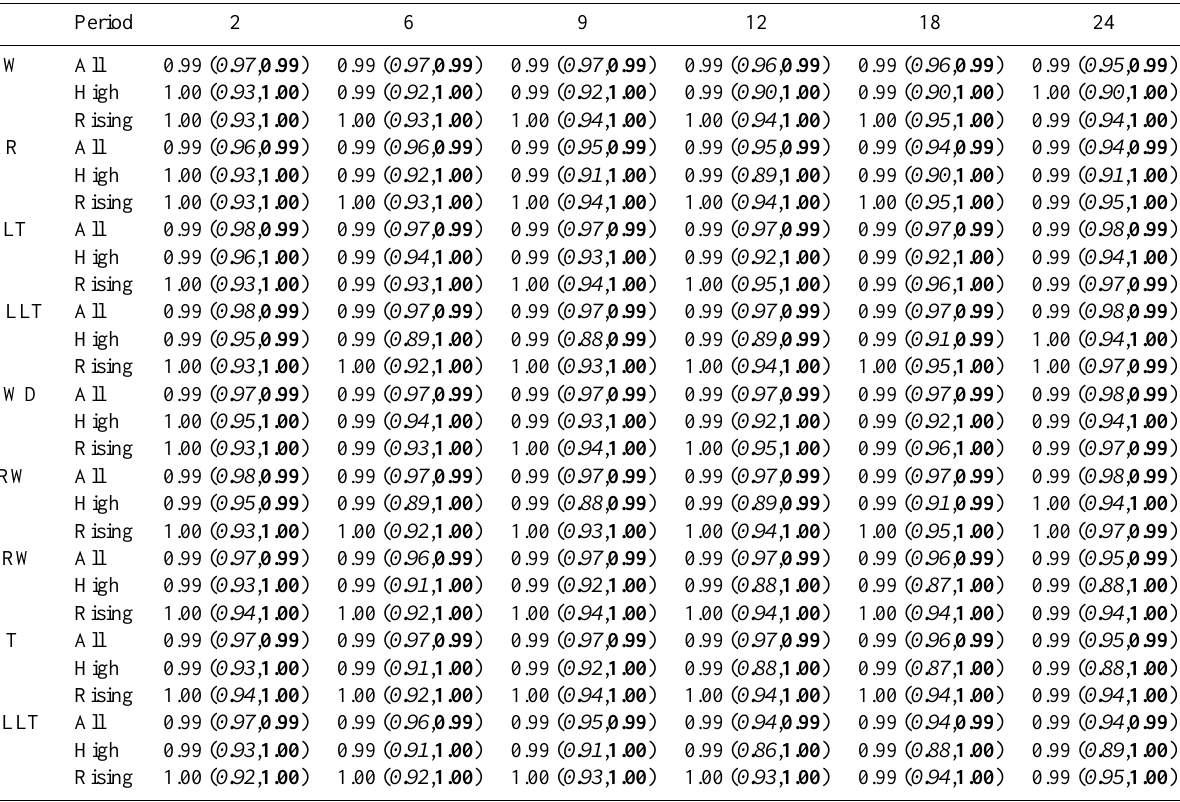
Table 5. Fraction of observations at Welsh bridge bracketed by the estimated 95% prediction intervals during validation. Bracketed results are those for the SEFE calibration with the italicised and bold values corresponding to the empirical and theoretical symmetric bounds. Results are shown for all the time periods, high levels ( > 2m) and periods where the hydrograph is rising for different combinations of lead time (hours) and GRW model.